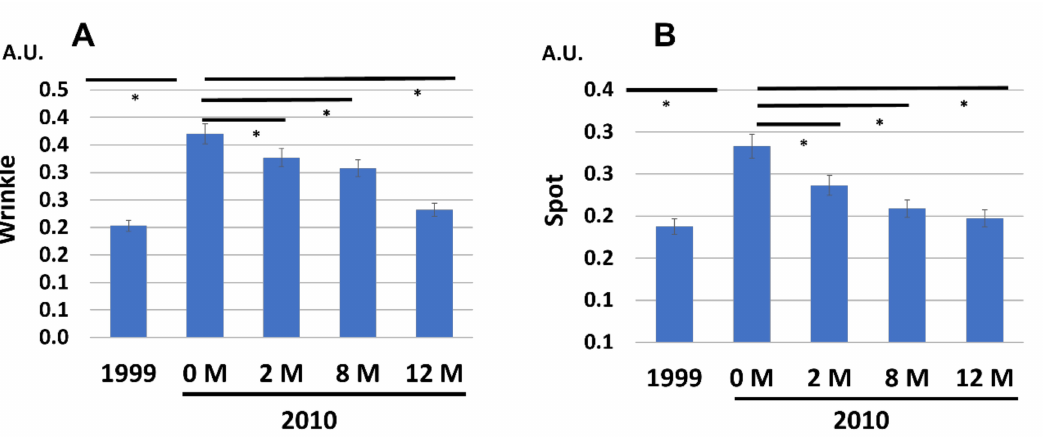
Figure 2. Chronological facial skin measurements in 1999 and in 2010 (at 0, 2, 8, and 12 M). All 86 subjects were treated with twice-daily application of G3 products for 12 M (0 M to 12 M). ( A ) Skin hydration. ( B ) TEWL. * p < 0.05.